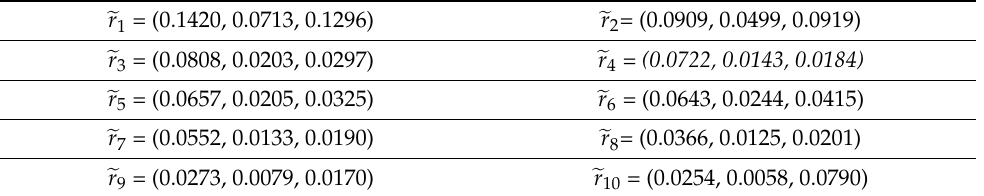
Table 6. The fuzzy return of each selected security.